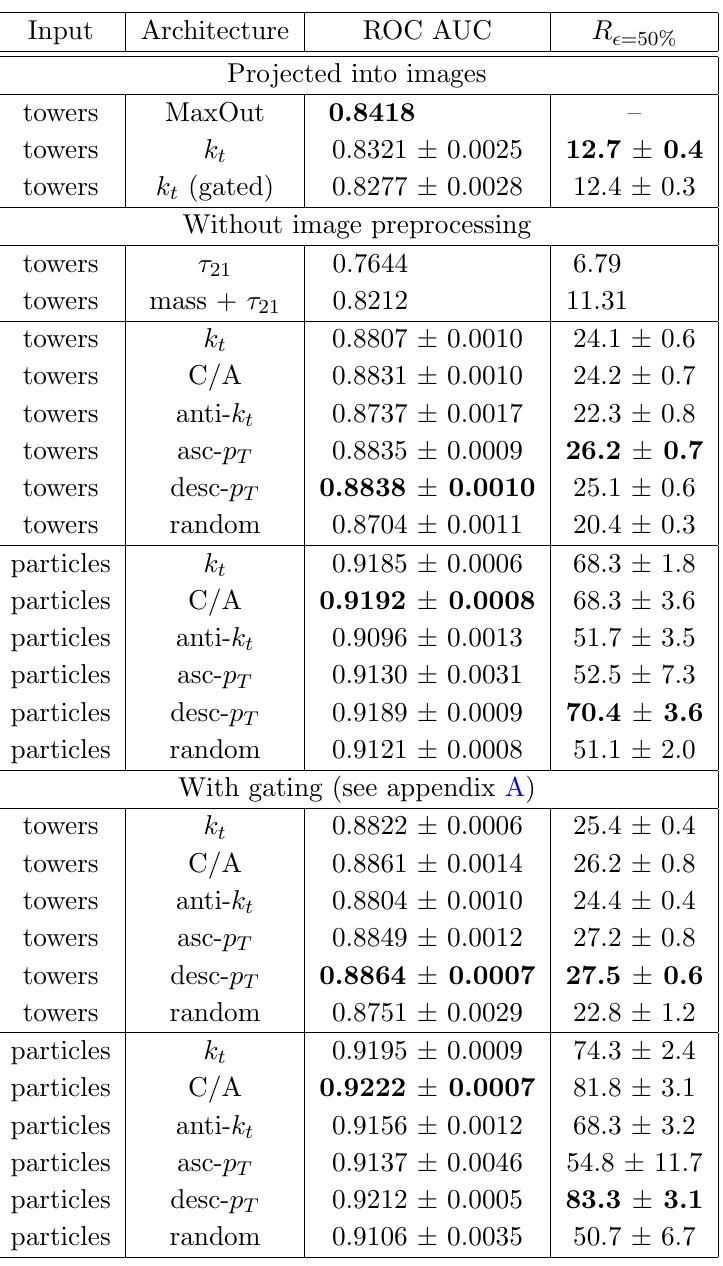
Table 1 . Summary of jet classi(cid:12)cation performance for several approaches applied either to particle- level inputs or towers from a DELPHES